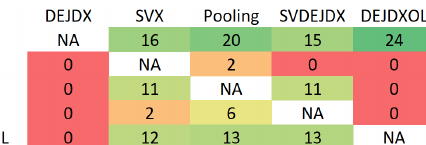
Figure 10. The results of the Diebold-Mariano tests at a significance level of 0.05 and for 24 h of the day with the pinball scoring rule in the out-of-sample period (2 January 2017–26 March 2017).